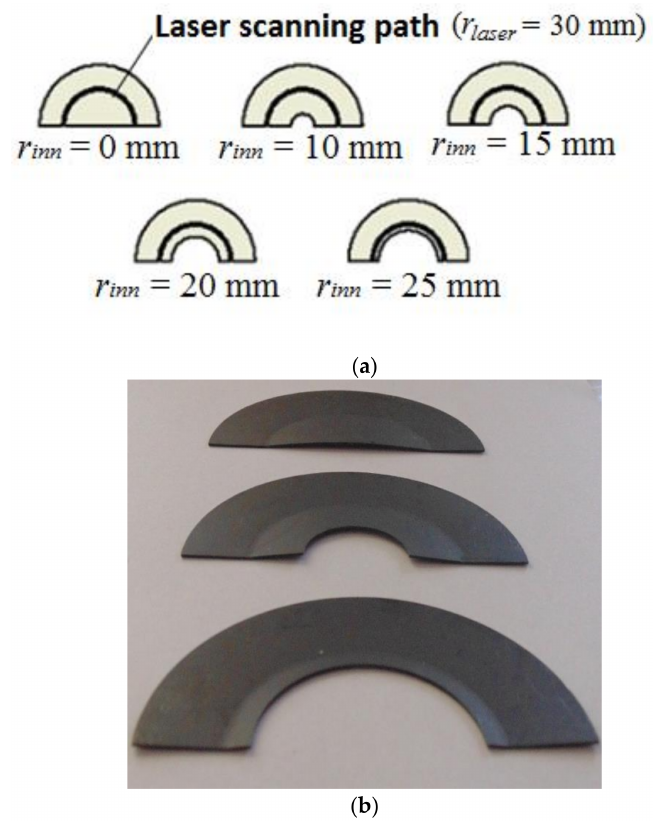
Figure 3. Multiple circular scanning path: ( a ) geometric configurations and ( b ) final bent sample of three of the studied configurations.